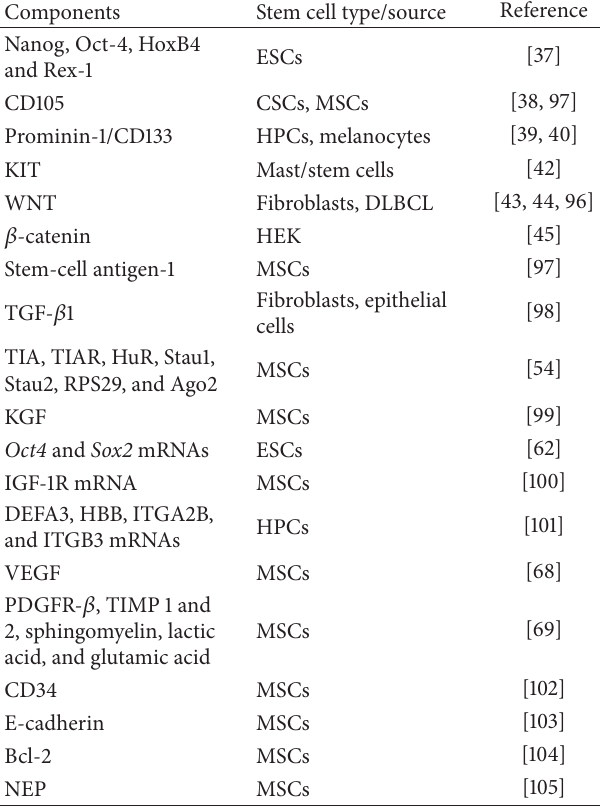
Table 1: Stem cell signatures expressed and secreted in EVs. Components Stem cell